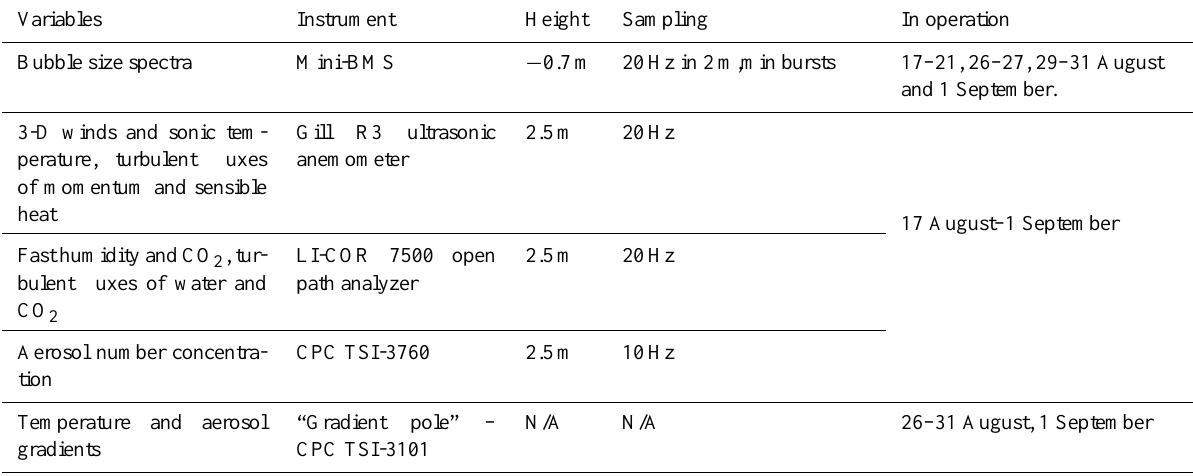
Table A3. Summary of the meteorological and oceanography instruments at the “Open Lead” aerosol flux site.